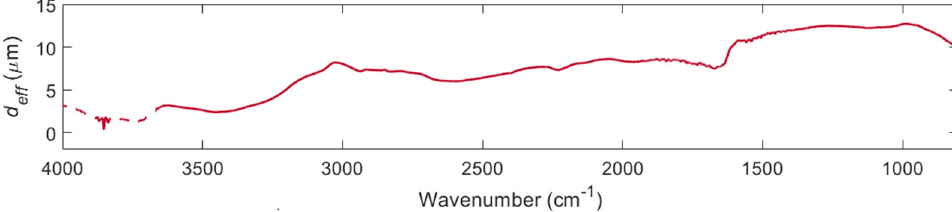
Figure 2. Empirical effective penetration depth d eff calculated from the measured absorbance and literature k values of water: The dashed trace at wavenumbers > 3700 cm − 1 show the region where d eff has been calculated from a ratio where both quantities are approximately equal to zero and therefore cannot be relied upon.